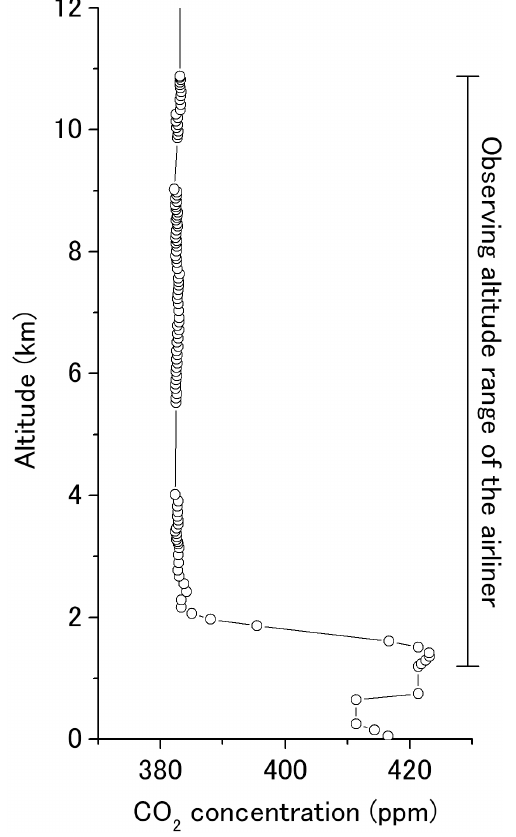
Fig. 3. An example of a profile of an inflowing air parcel from over the Tokyo metropolitan area to over Narita on 16 August 2007.